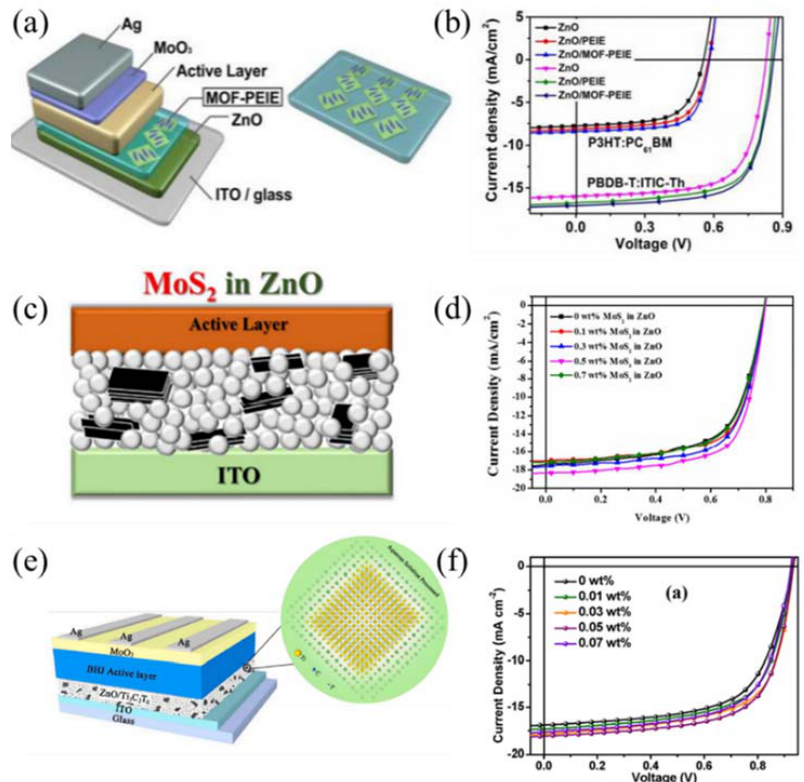
Figure 10. ( a ) The architectures of OPVs with ZnO ETL containing MOF-PEIE, and ( b ) the corresponding J–V characteristics based on P3HT:PC 61 BM and PBDB-T:ITIC-Th ( c ) the structure of MoS 2 in ZnO ETL, and ( d ) the corrensponding J-V characteristics based on PTB7-TH:PC 71 BM with ZnO ETL in different incorporation of MoS 2 ( e ) the structure of OSCs based on PBDB-T:ITIC with Ti 3 C 2 T X , and ( f ) the corresponding J-V characteristics based on PBDB-T:ITIC with Ti 3 C 2 T X . Reprinted with permission form [91,97,98]. Copyright 2018 Elsevier Ltd., 2018 American Chemical Society and 2021 Elsevier